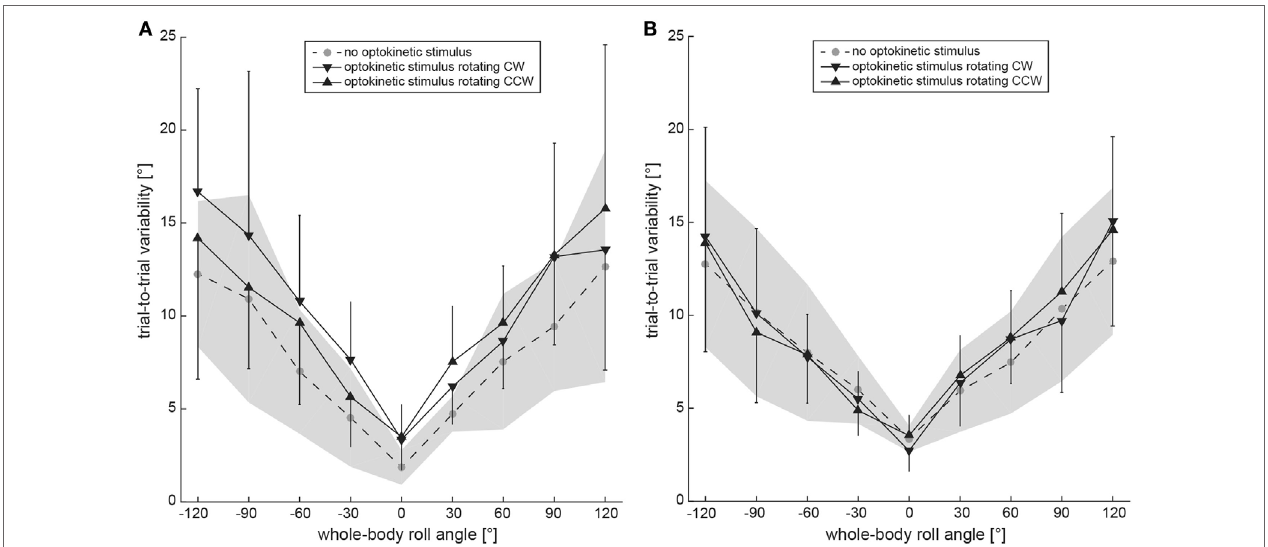
FigUre 5 | Overall mean trial-to-trial variability values for the subjective visual vertical (SVV) paradigm (a) and the subjective haptic vertical (SHV) paradigm (B) are plotted against whole-body roll orientation for both test and control trials. Whereas the gray circles interconnected by a dashed line refer to the control condition without optokinetic stimulation, the inverted black triangles indicate variability values from the optokinetic CW condition and the black triangles are linked to the optokinetic CCW condition. The gray-shaded area indicates ± 1 SD for the control condition and the bars refer to ± 1 SD in the test